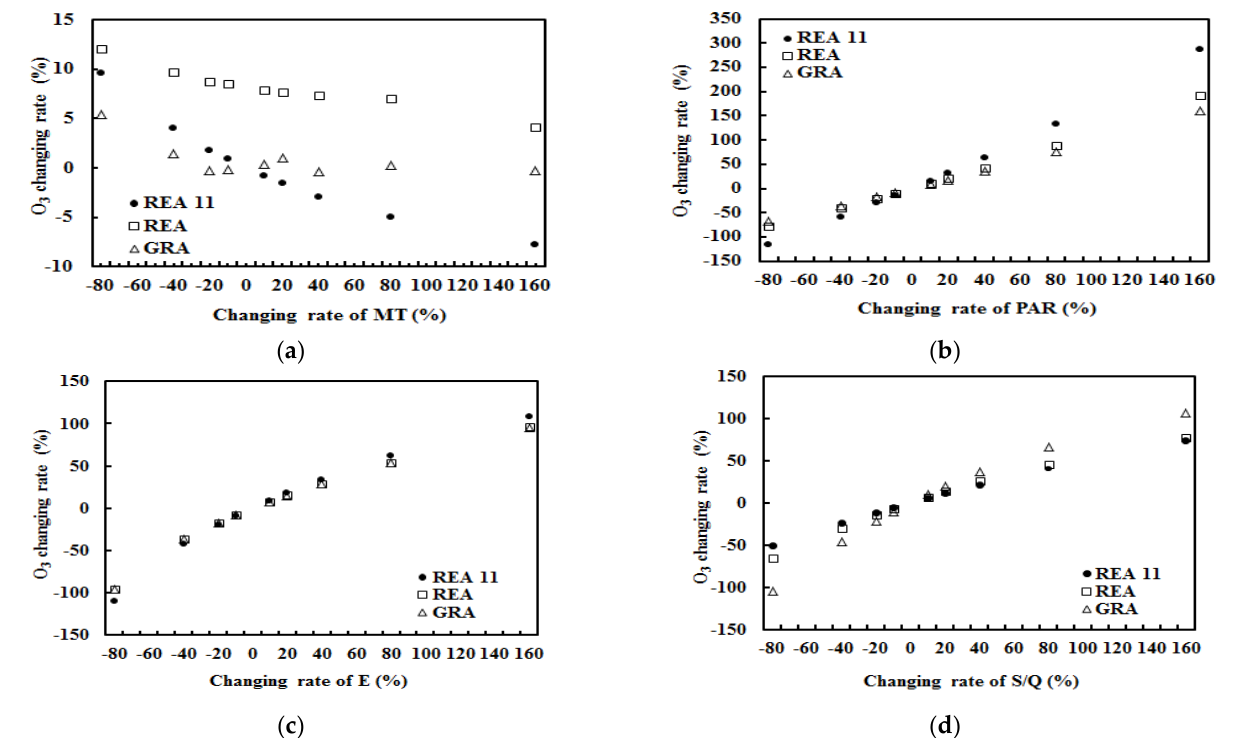
Figure 6. O 3 changing rates (%) with the change of one factor (monoterpenes, or PAR, E, S/Q for situations of ( a – d ), respectively) and other factors kept at their original levels under realistic atmospheric conditions. REA and GRA denote the emission data were measured by REA and gradient technique, respectively. REA11 denotes the monoterpene emission data used in model development (O 3 empirical model considering monoterpene roles).